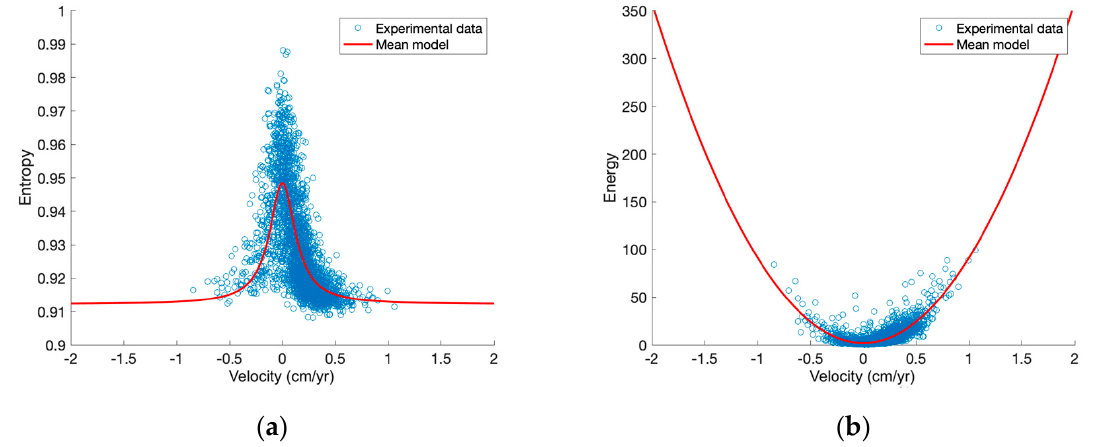
Figure 19. Correlation between LOS velocity and entropy–energy dispersion for the Colosseum in the period from 2011 to 2015: ( a ) Entropy–velocity dispersion; ( b ) Energy–velocity dispersion.